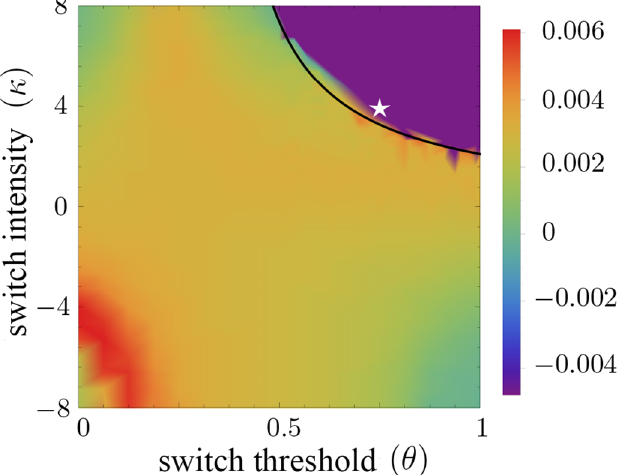
Fig 2. Total population growth rate of the resting cell population depends on the phenotypic switch parameters κ and θ . Initially, in a radius of 10 [unit length] from the center one rest and one velocity channel per node are occupied. Parameters are r b = 0.2, r d = 0.01, K = 8. Simulations are performed for 1000 iteration steps steps. The color indicates the total population growth rate of the resting cell population. The dark purple region denotes population extinction. The black curve is given by the equality r s ( % ) = r d /r b , with % = 0.25. The inequality derived in Eq (3) approximates the ( θ , κ )-parameter region for which population extinction is observed. The white star represents the specific ( κ , θ )-values for which subsequent analysis of the frequency of population extinction in Fig 3 is performed.